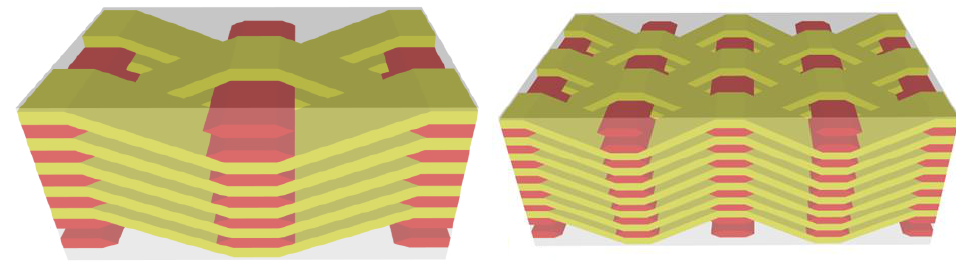
Figure 9. The micromodel of 2.5D braided composites.